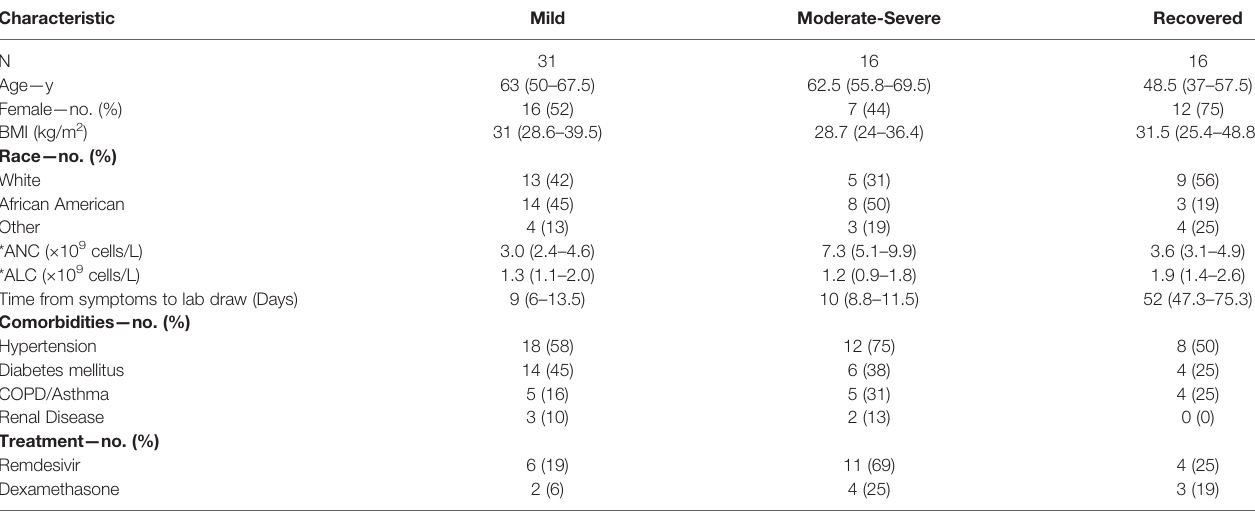
TABLE 1 | COVID-19 participant characteristics (% or median values with IQR in